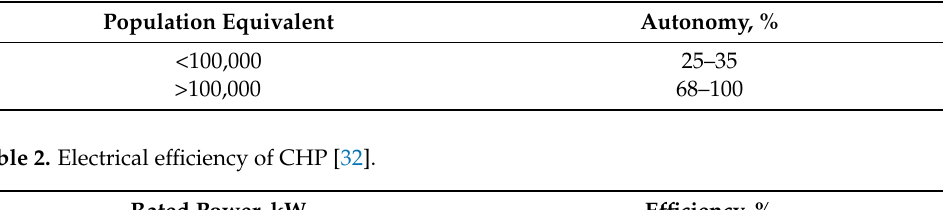
Table 1. Electricity autonomy of WWTPs in the case of CHP use [32].